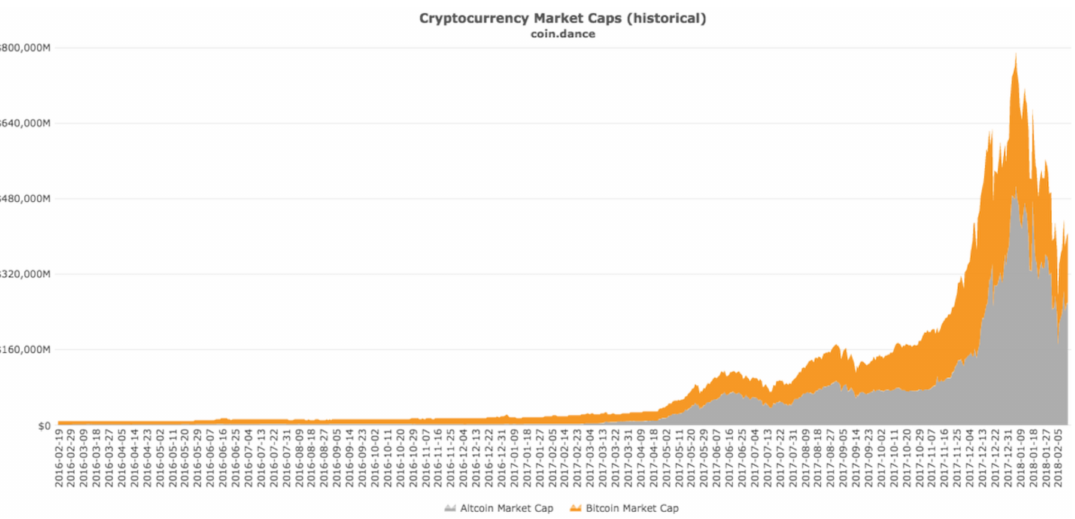
Figure 2. Overall Bitcoin and Altcoin cryptocurrency market gains and losses from 19 February 2016 through 5 February 2018 (Coin Dance